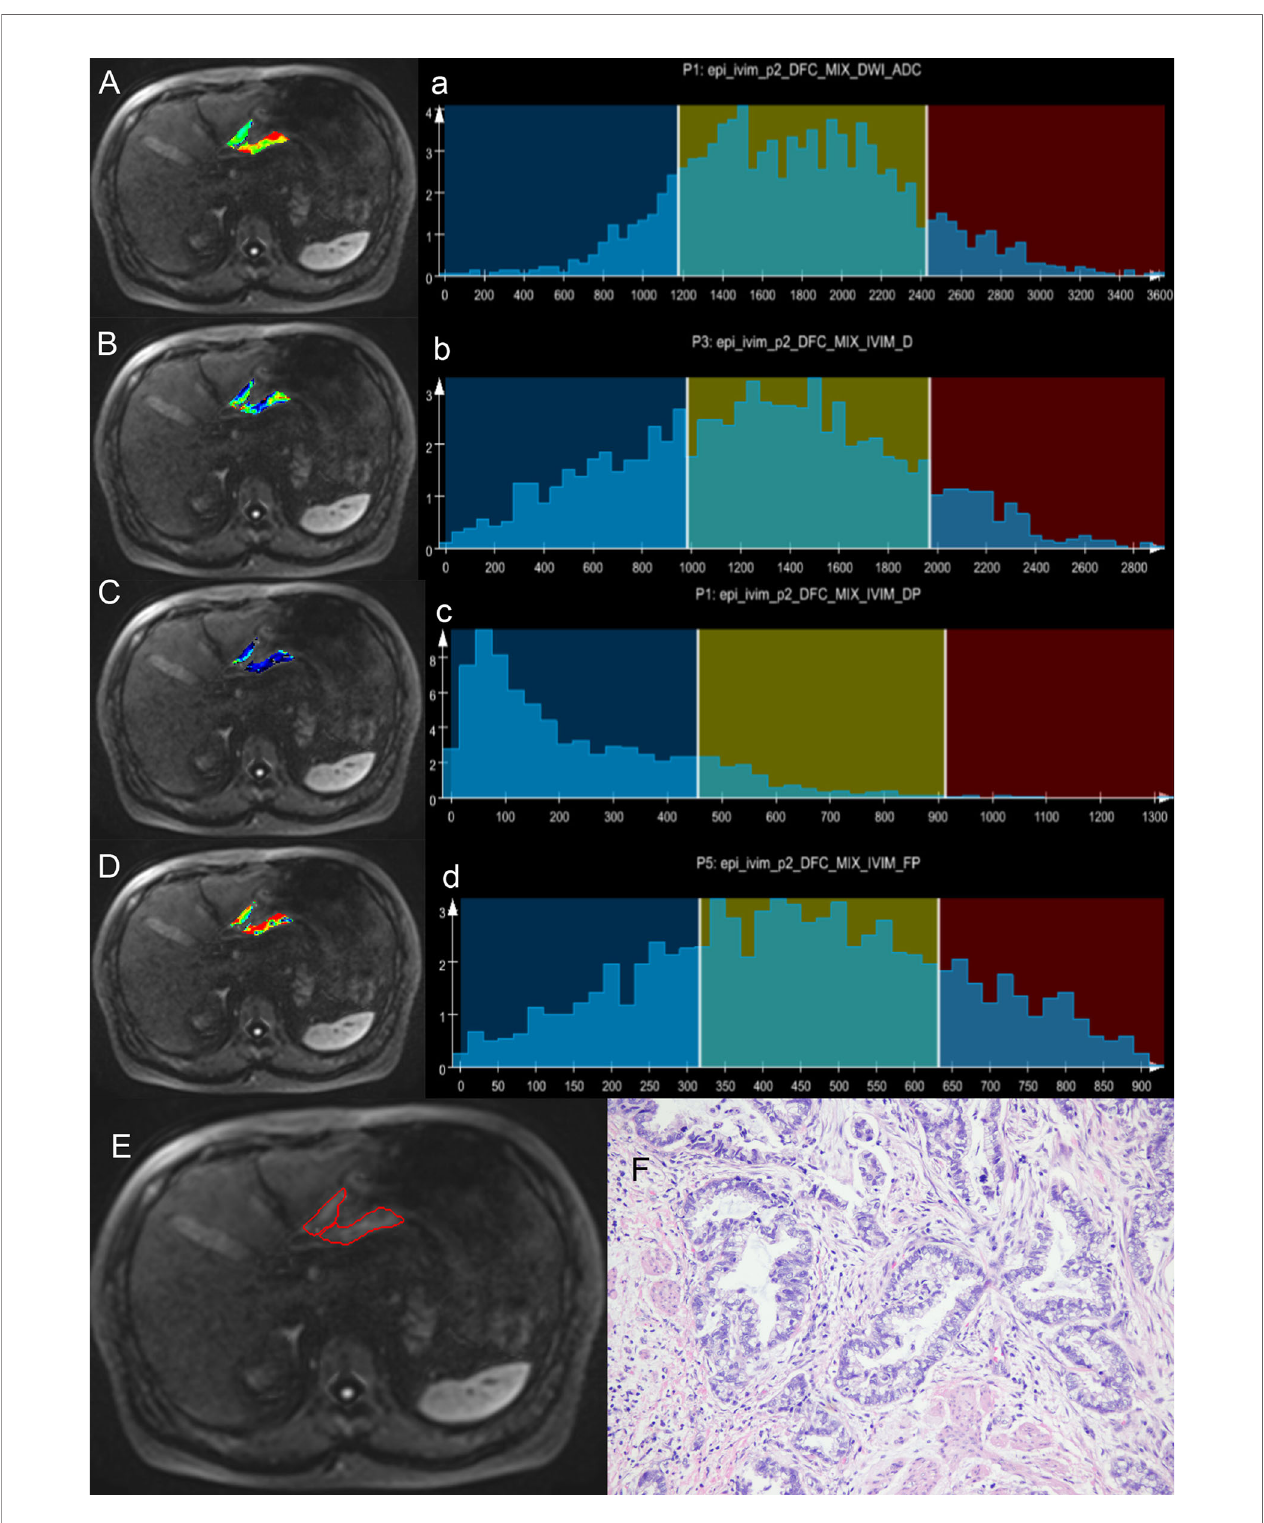
FIGURE 2 | A case of gastric antrum cancer. The colored regions in (A – D) represent the lesion parameters maps; (a – d) show histogram parameter distributions for the whole tumor (ADC, Dslow, Dfast, and FP presenting sequentially). (E) Shows the contour of the region of interest (ROI). (F) A photomicrograph of an HE stained tissue section demonstrating a moderately differentiated